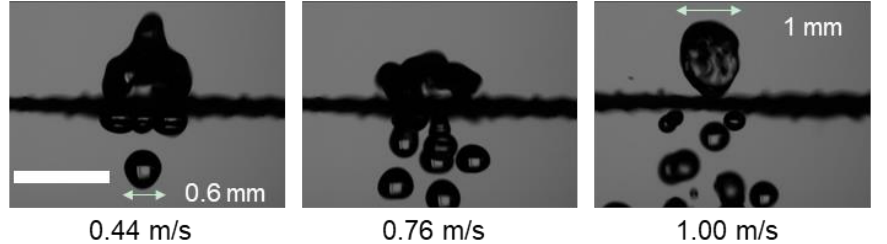
W e Figure 9. Normalized contact time of a droplet on the superhydrophobic mesh. The impacting velocity affects the dividing process of the impacting droplet on the superhydrophobic mesh significantly. As shown in Figure 10, as the impacting speed in- creases, the number of divided tiny droplets that pass through the superhydrophobic mesh increases. For example, when the impacting speed is 0.44 m/s on 2# superhydropho- bic mesh, where the width of the mesh gap is 0.9 mm, only one tiny droplet (with a diam-